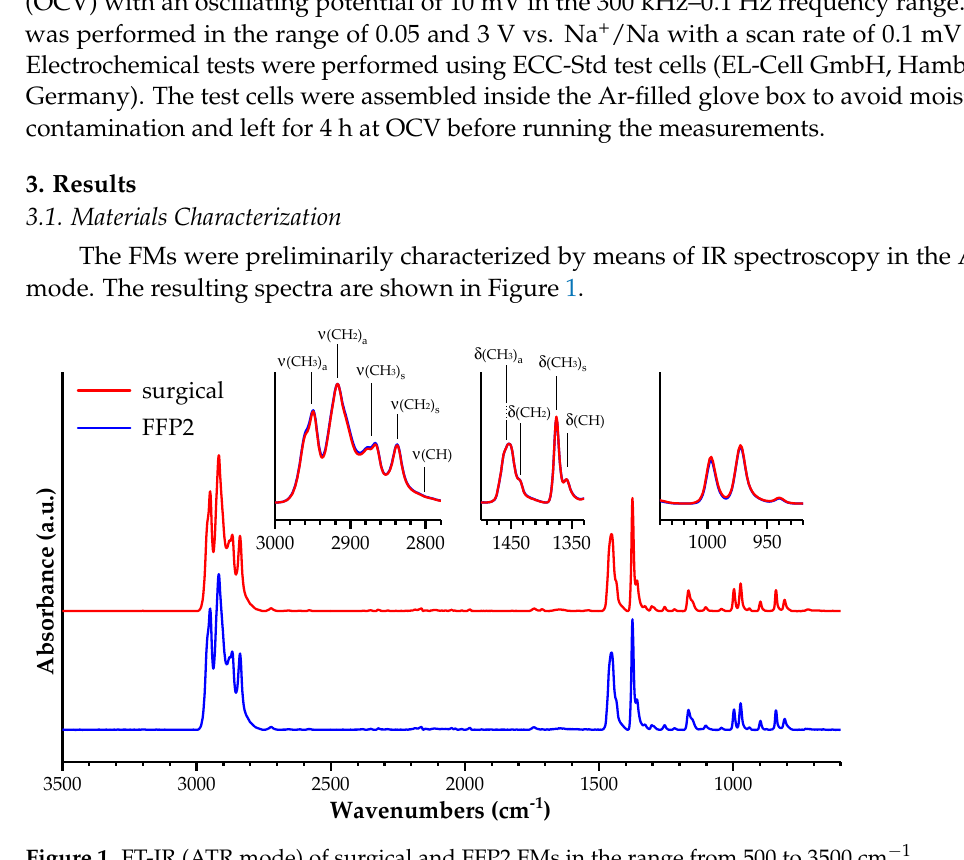
Figure 1. FT-IR (ATR mode) of surgical and FFP2 FMs in the range from 500 to 3500 cm − 1 . Accordingly to Fadare et al. [2], both surgical and FFP2 face masks are mainly composed of fibers of polypropylene (PP). Indeed, both spectra showed the characteristic features of PP, such as the asymmetric and symmetric ν (CH 3 ) at 2950 and 2868 cm − 1 (with shoulders at 2959 and 2877 cm − 1 because of different phase resonance among neighboring units), the asymmetric and symmetric ν (CH 2 ) at 2918 cm − 1 and 2838 cm − 1 , the asymmetric and symmetric δ (CH 3 ) at 1456 cm − 1 and 1375 cm − 1 , δ (CH 2 ) at 1437 cm − 1 and δ (CH) at 1359 cm − 1 [36]. Moreover, the relative intensities of the vibrational modes of the polymer backbone (below 1000 cm − 1 ) could be used to acquire information on the propylene stereoregularity on the basis of the characterization method developed by Burfield and Loi [37]. The method indicated that both samples were characterized by a high degree of isotacticity (up to almost 80%) with no significant differences. As a matter of fact, the similar composition of the surgical and FFP2 FMs was also reflected in their thermal behavior towards degradation in an inert atmosphere. The two TGA profiles shown in Figure 2 were quite close, with a very sharp weight loss above 450 °C and a minimal solid residue remaining up to 800 °C, this being higher for the surgical FMs than for FFP2 (1.05 against 0.46 wt.%).